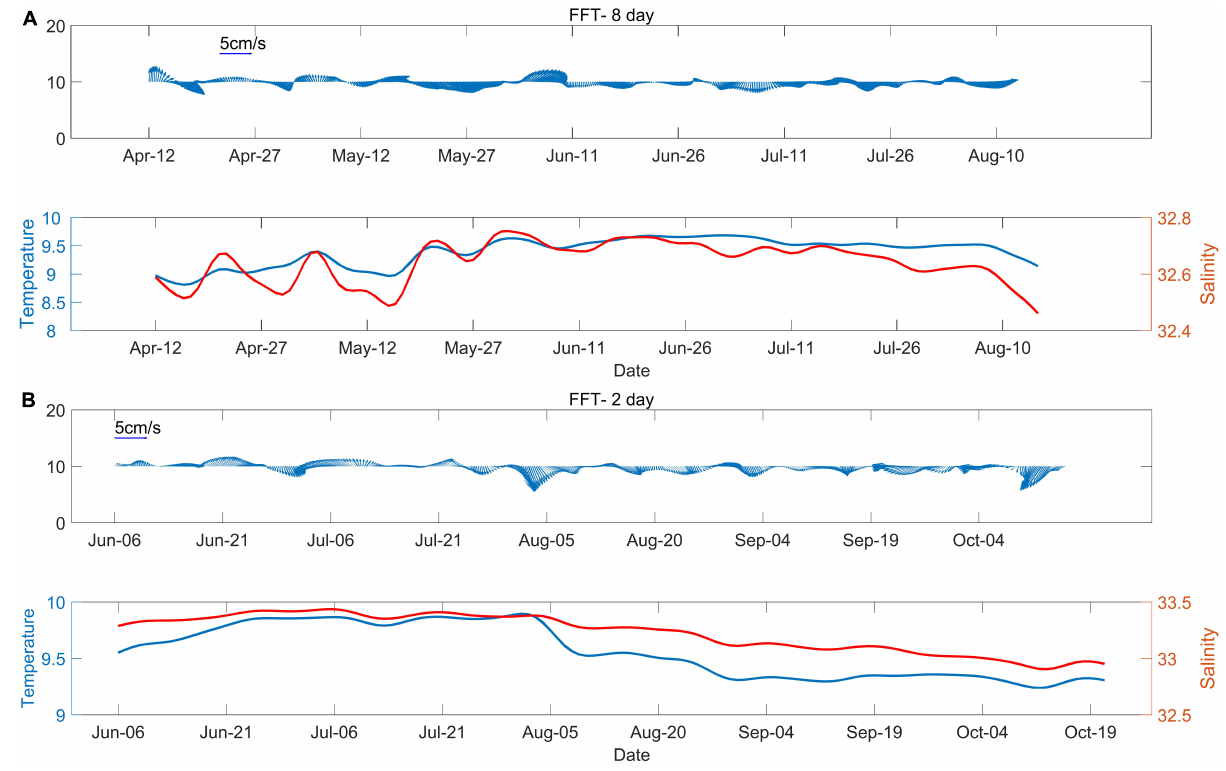
Frontiers in Marine Science |